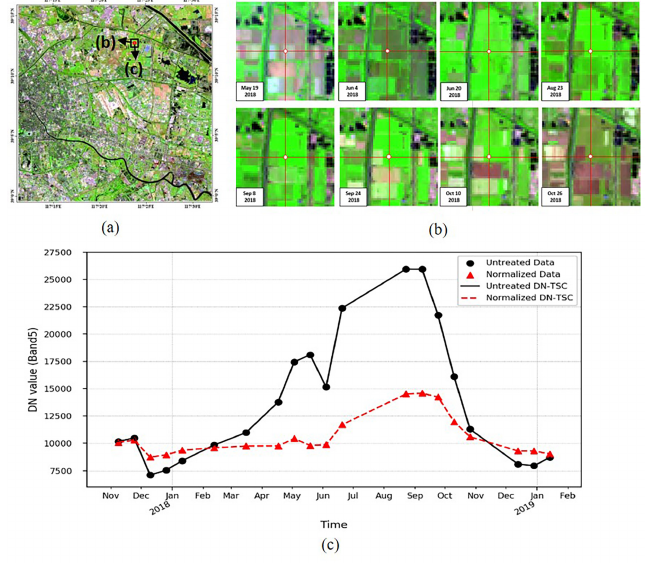
Figure 8. The relative radiometric normalization results of DN values of cropland pixels. ( a ) The location of cropland pixels and the boundary of crop images are marked in red point and black box, respectively. ( b ) The cropland images during the growth period of corn. ( c ) The Comparison of the DN-TSC from the near-infrared Band (band 5) for the cropland pixel before (marked by a black line) and after (marked by a red line) the radiometric